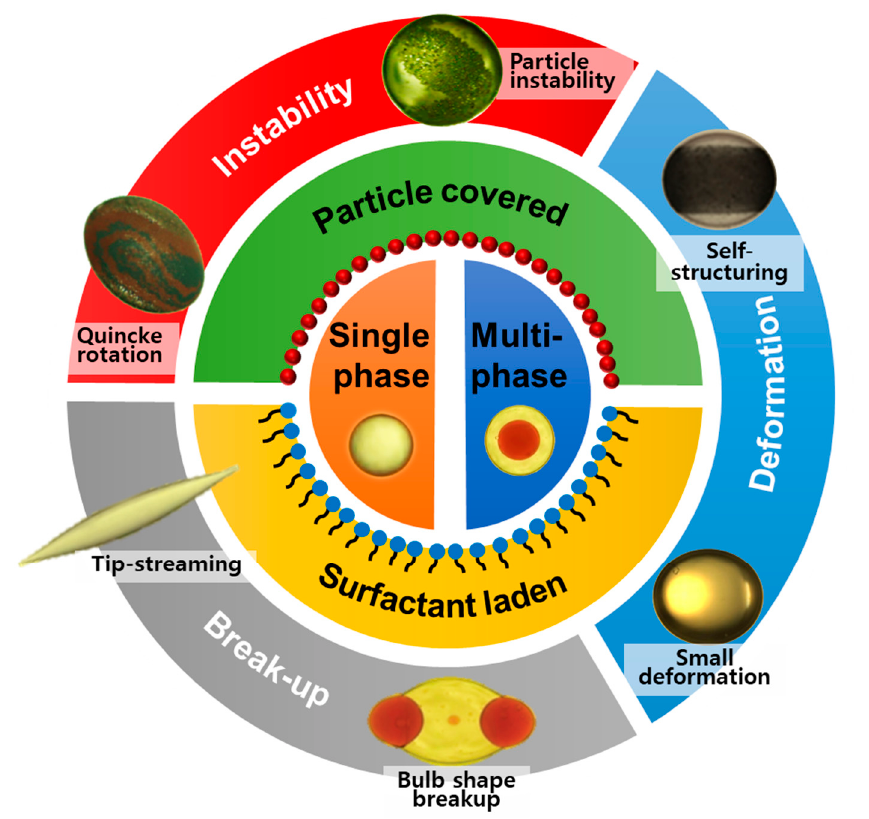
Figure 1. Hydrodynamics of emulsion droplets under an electric field.